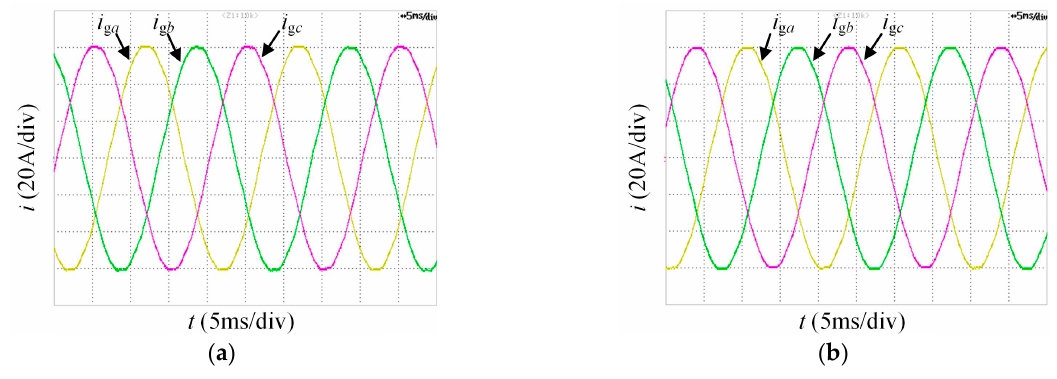
Figure 15. Steady-state full-load output current with different equivalent grid-impedances. ( a ) L g = 0.5 mH; and ( b ) L g = 0.8 mH.